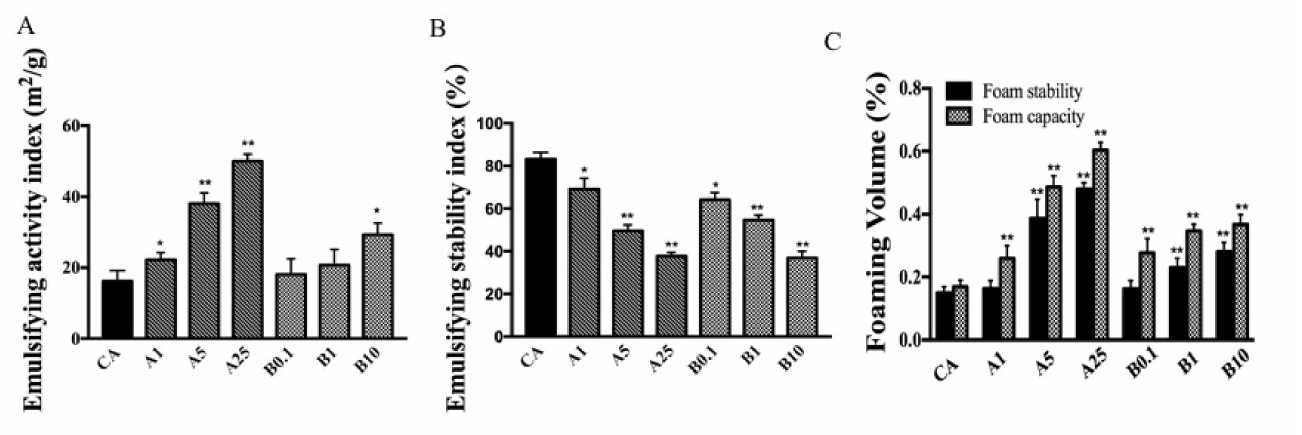
Figure 3. ( A ) Emulsifying activity, ( B ) emulsifying stability, and ( C ) foaming properties of CA, AAPH-CA, and acrolein-CA. * represents significant differences when compared with CA; * p < 0.05; ** p <